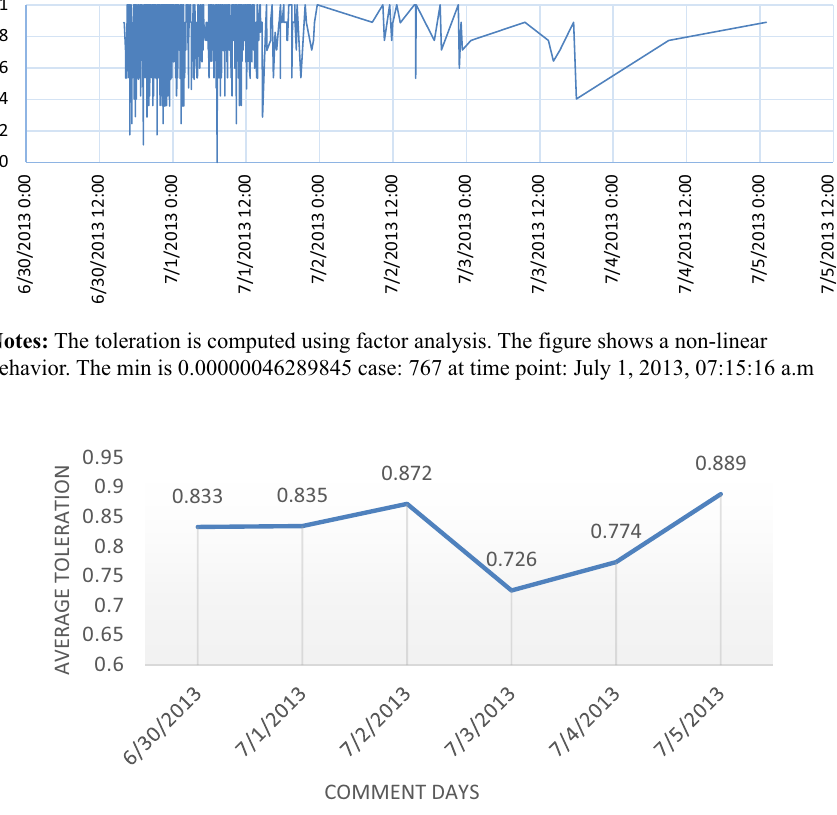
Figure 13. Average